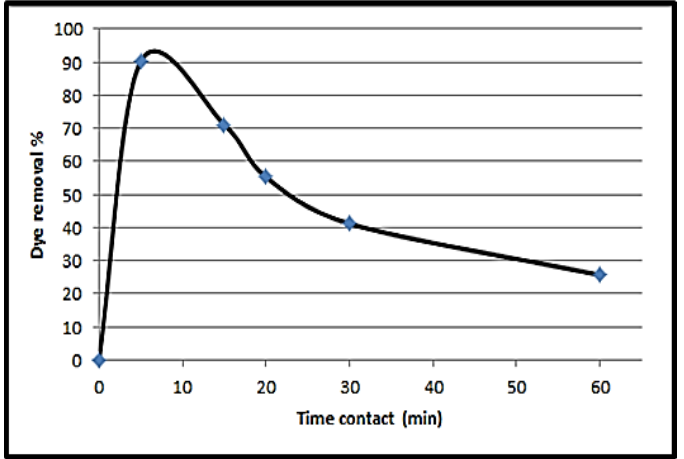
Figure 8. The contact time impact for Congo red removal using NPS (pH = 7; adsorbent dose = 10 g/L; initial CR concentration = 10 mg/L). 10 g/L; initial CR concentration = 10